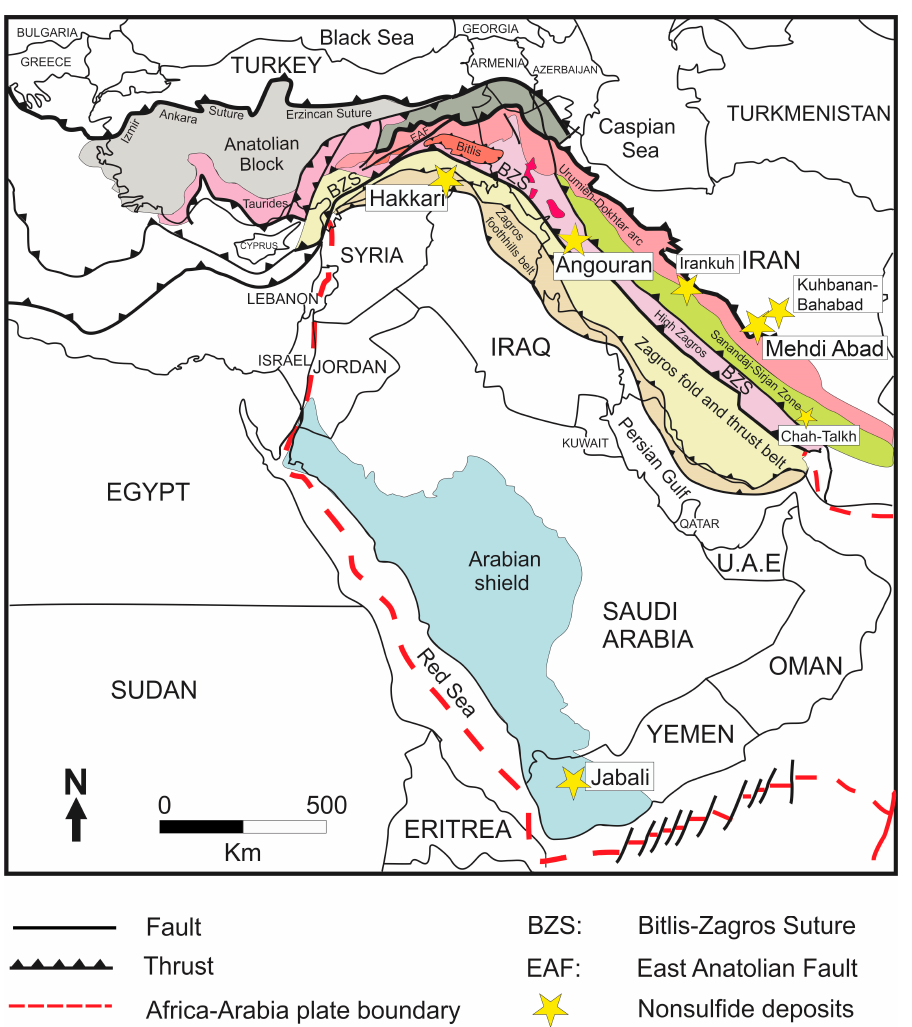
Figure 1. Map of the Middle East region, with major structural units and location of the nonsulfide Zn deposits where C–O stable isotope data have been published.